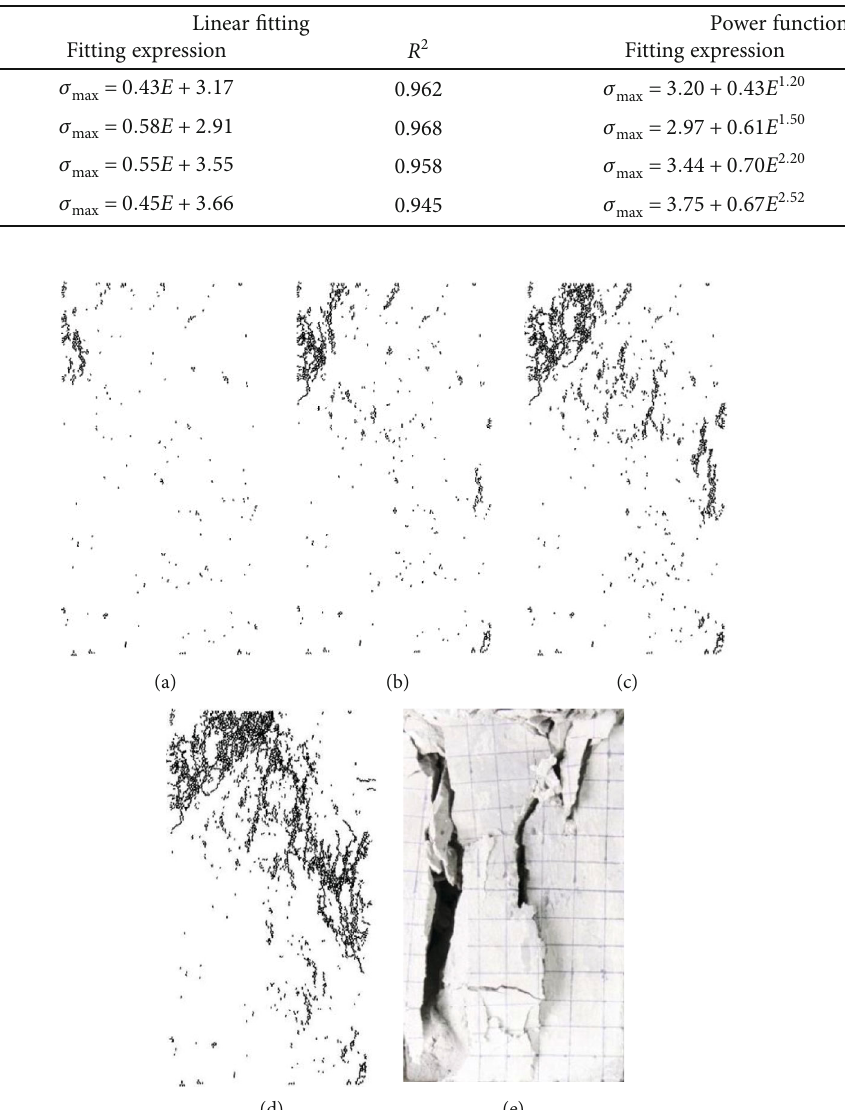
Table 3: Peak strength-strain rate fi tting expression.